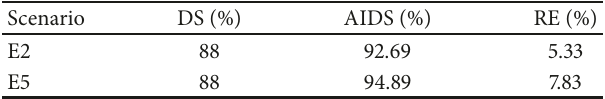
Table 13: Average of identified damage severities based on PC and